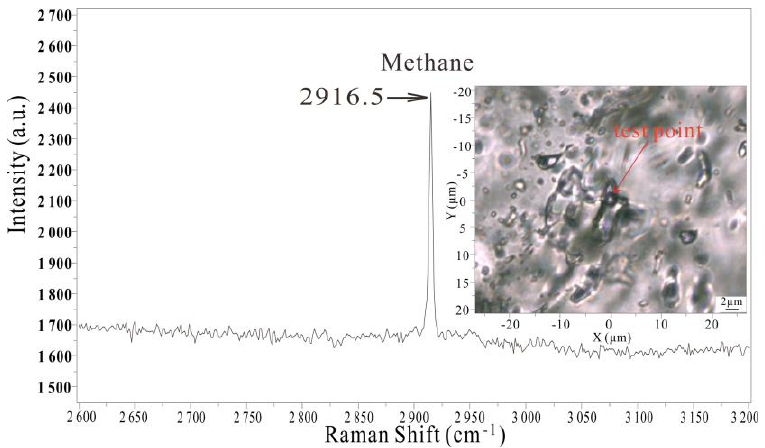
Figure 7. Laser Raman spectroscopy of gas inclusions in the WS1 well. The horizontal and vertical lines show the Raman Shift and intensity of the tested gas inclusion.